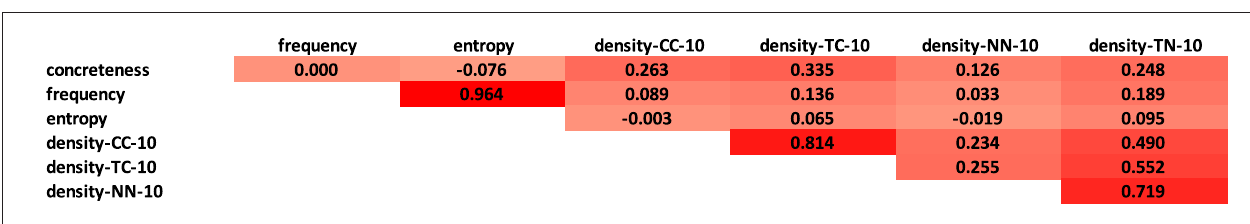
FIGURE 11 | Results across combinations of hypernymy levels for nouns.